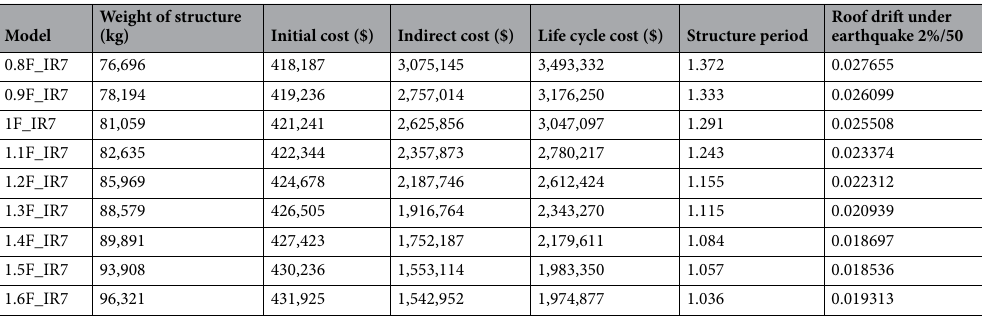
Table 5. Results of 7-story irregular structures under different seismic loads.